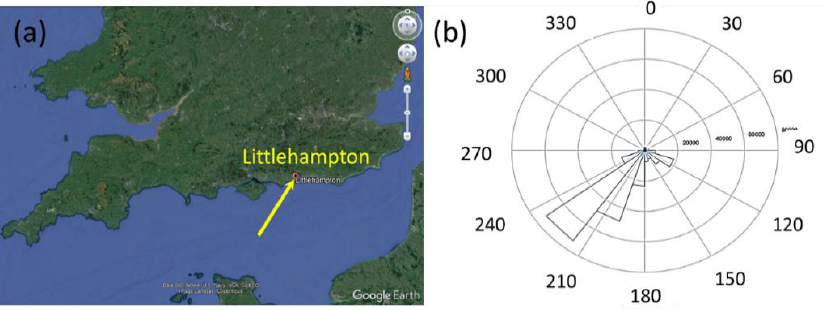
Figure 3. ( a ) Littlehampton beach lies in Southeast England; ( b ) a rose diagram illustrating the predominant wave direction from southwest to northeast,where the numbers indicate degrees from North.